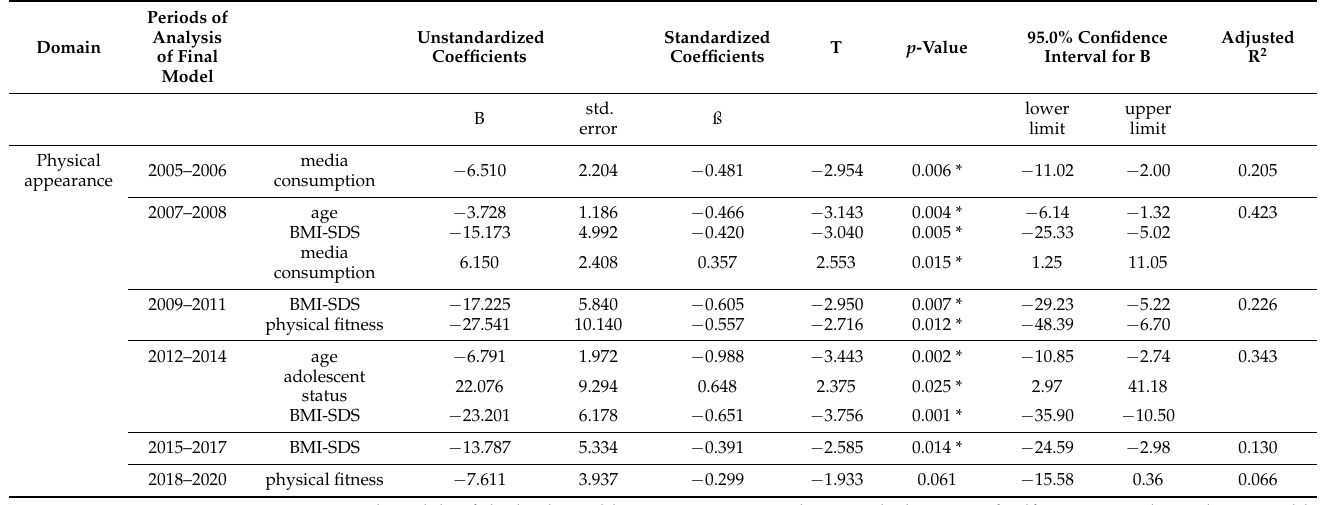
Table 4. Linear regression analysis (backward) of the physical appearance